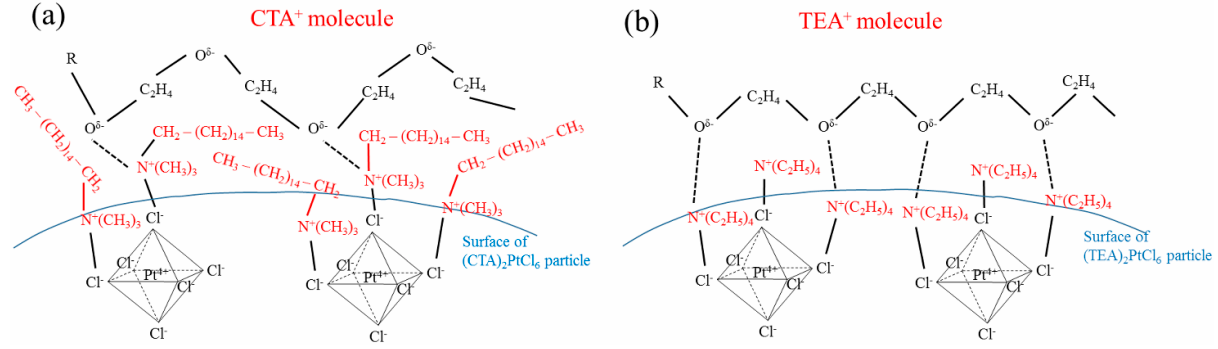
Figure 5. Surface images of complex particles using different complex-forming agents. ( a ) Complex-forming agent occupies a large volume; ( b ) Complex-forming agent